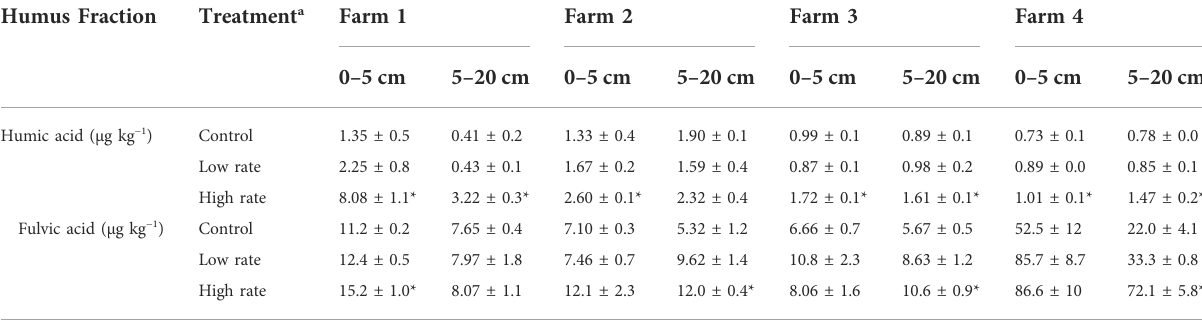
TABLE 3 Effect of compost application at two rates on Cd distribution among soil humus fractions at two depths in four cacao sites.